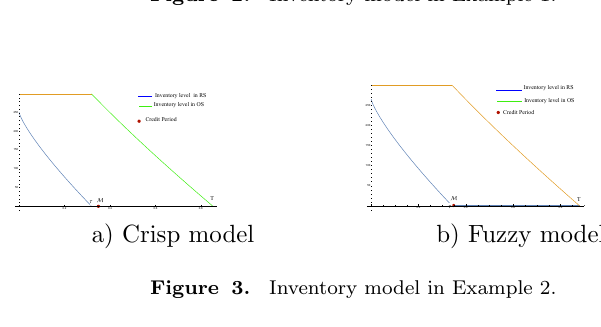
Figure 3. Inventory model in Example 2.